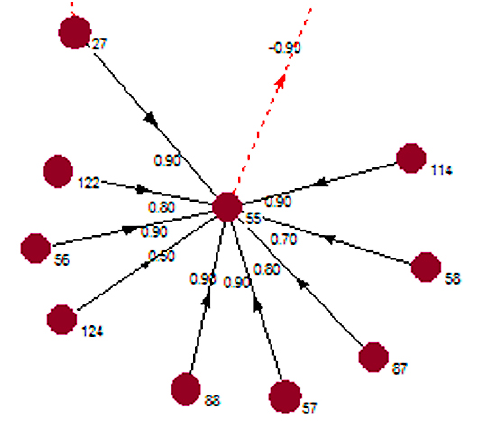
Fig. 7. Quantification of relationships